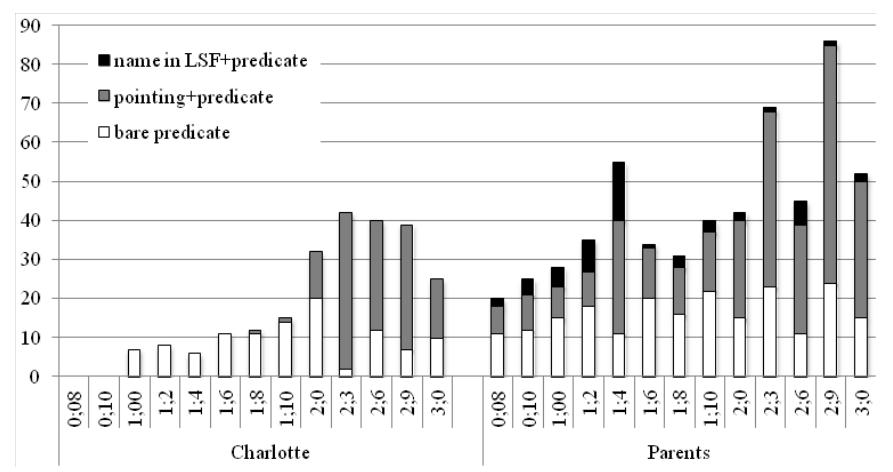
Figure 5. Subject self-reference (bare predicate, name and self-pointing) in Charlotte and her parents’ data according to